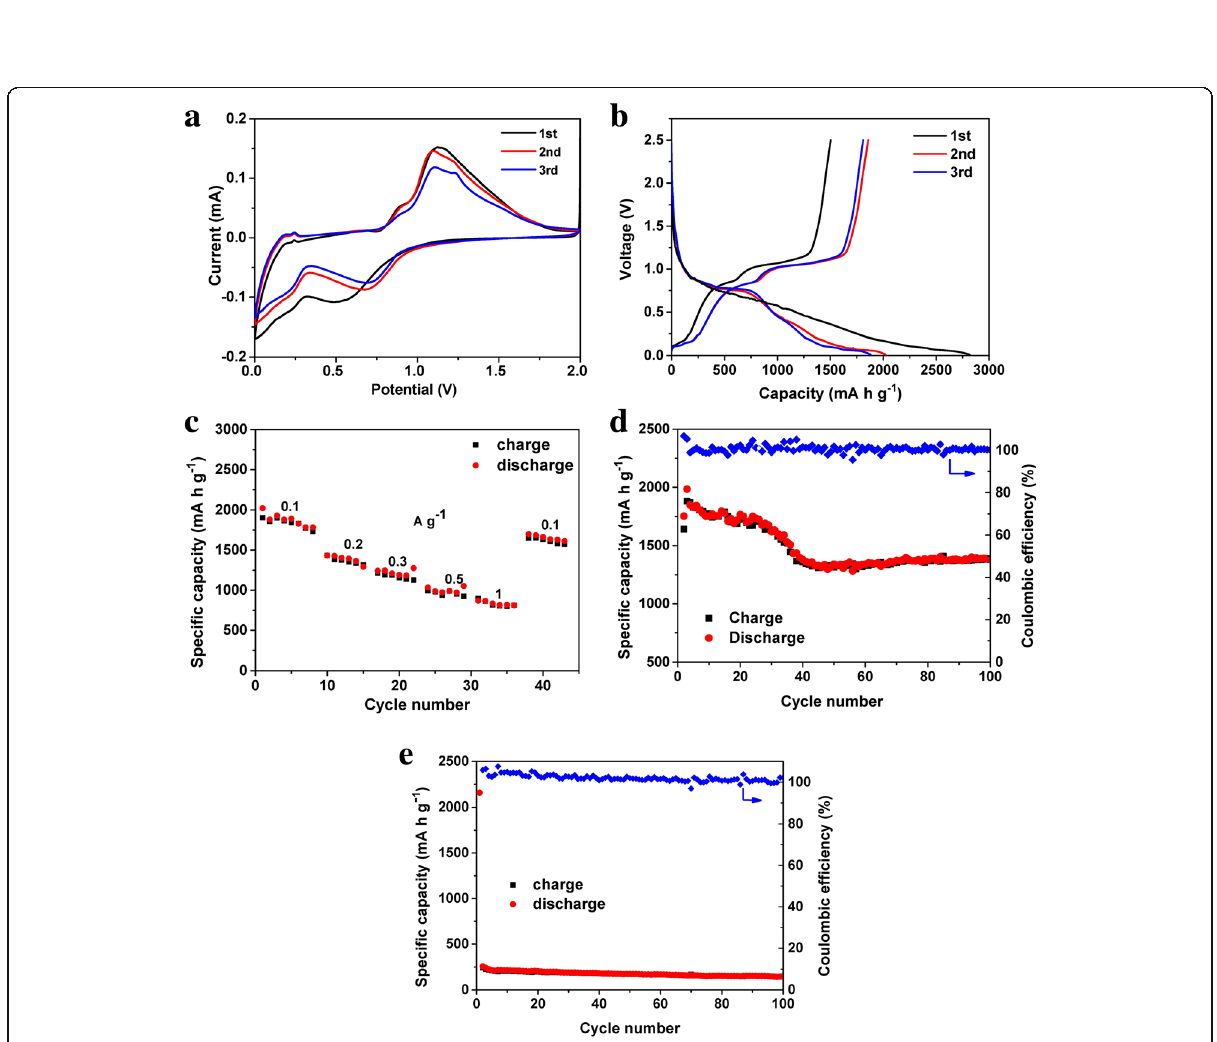
Fig. 5 Electrochemical performance of RPNPs. a CV curves of the RPNPs. b Voltage profiles of the RPNPs. c Rate performance of the RPNPs cycled at different current densities. d Cycling performance of RPNPs at a rate of 0.1 A g − 1 . e Cycling performance of commercial RP at a rate of 0.1 A g −